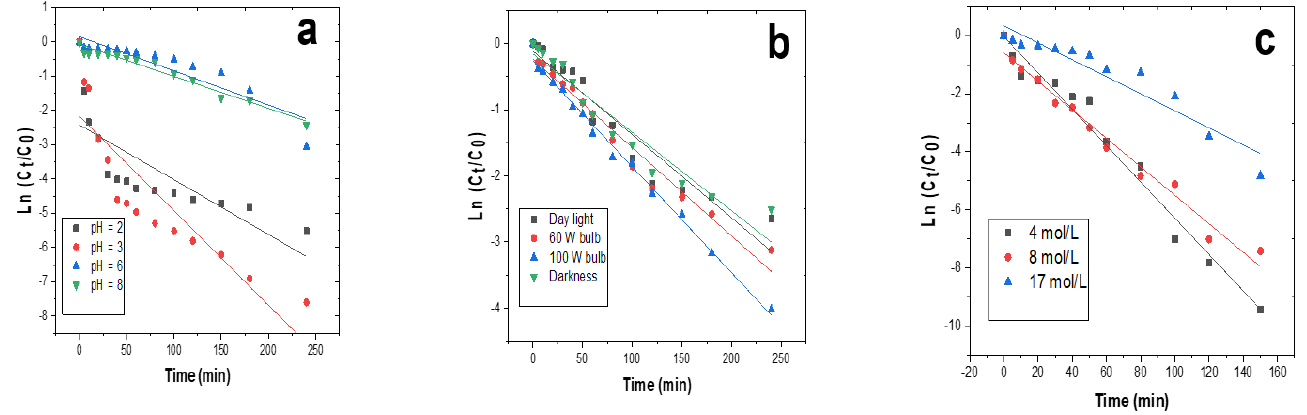
Figure 9. Linear regression plots of the first-order kinetics of indigo carmine degradation reactions under the influence of pH ( a ), light intensity ( b ) and H 2 O 2 concentration ( c ). Table 1. First-order rate constants and half-lives for degradation of indigo carmine. Parameters